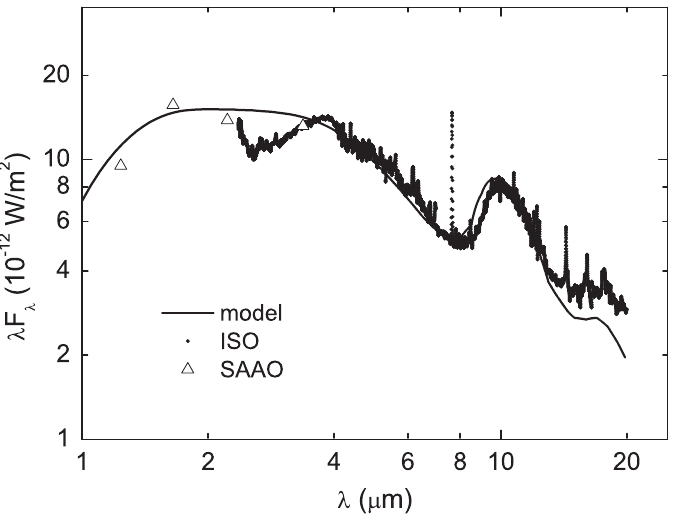
Fig. 1. Spectral energy distribution constructed from SAAO photometry and ISO spectra during the epoch outside dust obscuration events. The best (cid:12)t two-component theoretical model is also shown, the parameters of which are given in Table